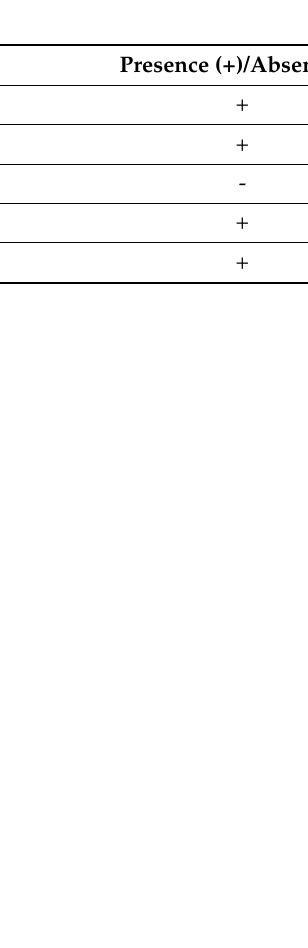
Figure 1. Color change indication of formation of